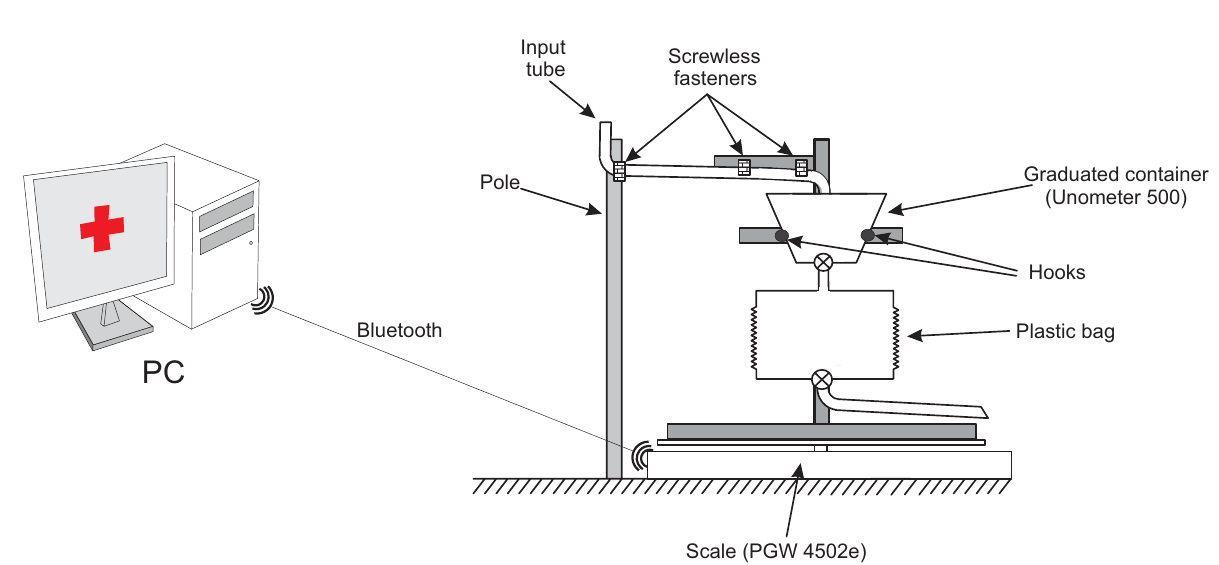
Figure 2. Device